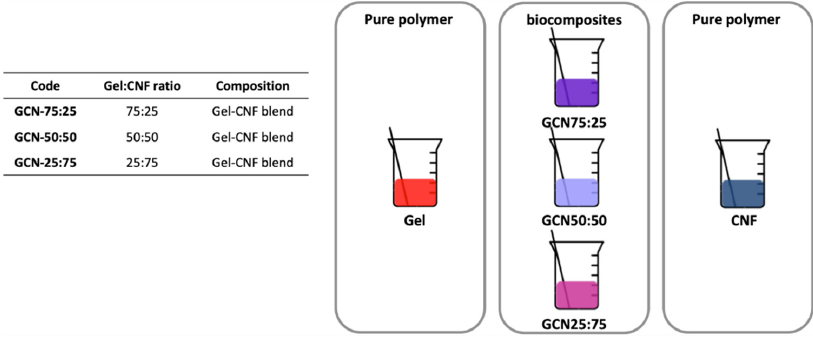
Figure 1. Representation of gelatin (Gel) and cellulose nanofibrils (CNFs) ratio in the developed blends.